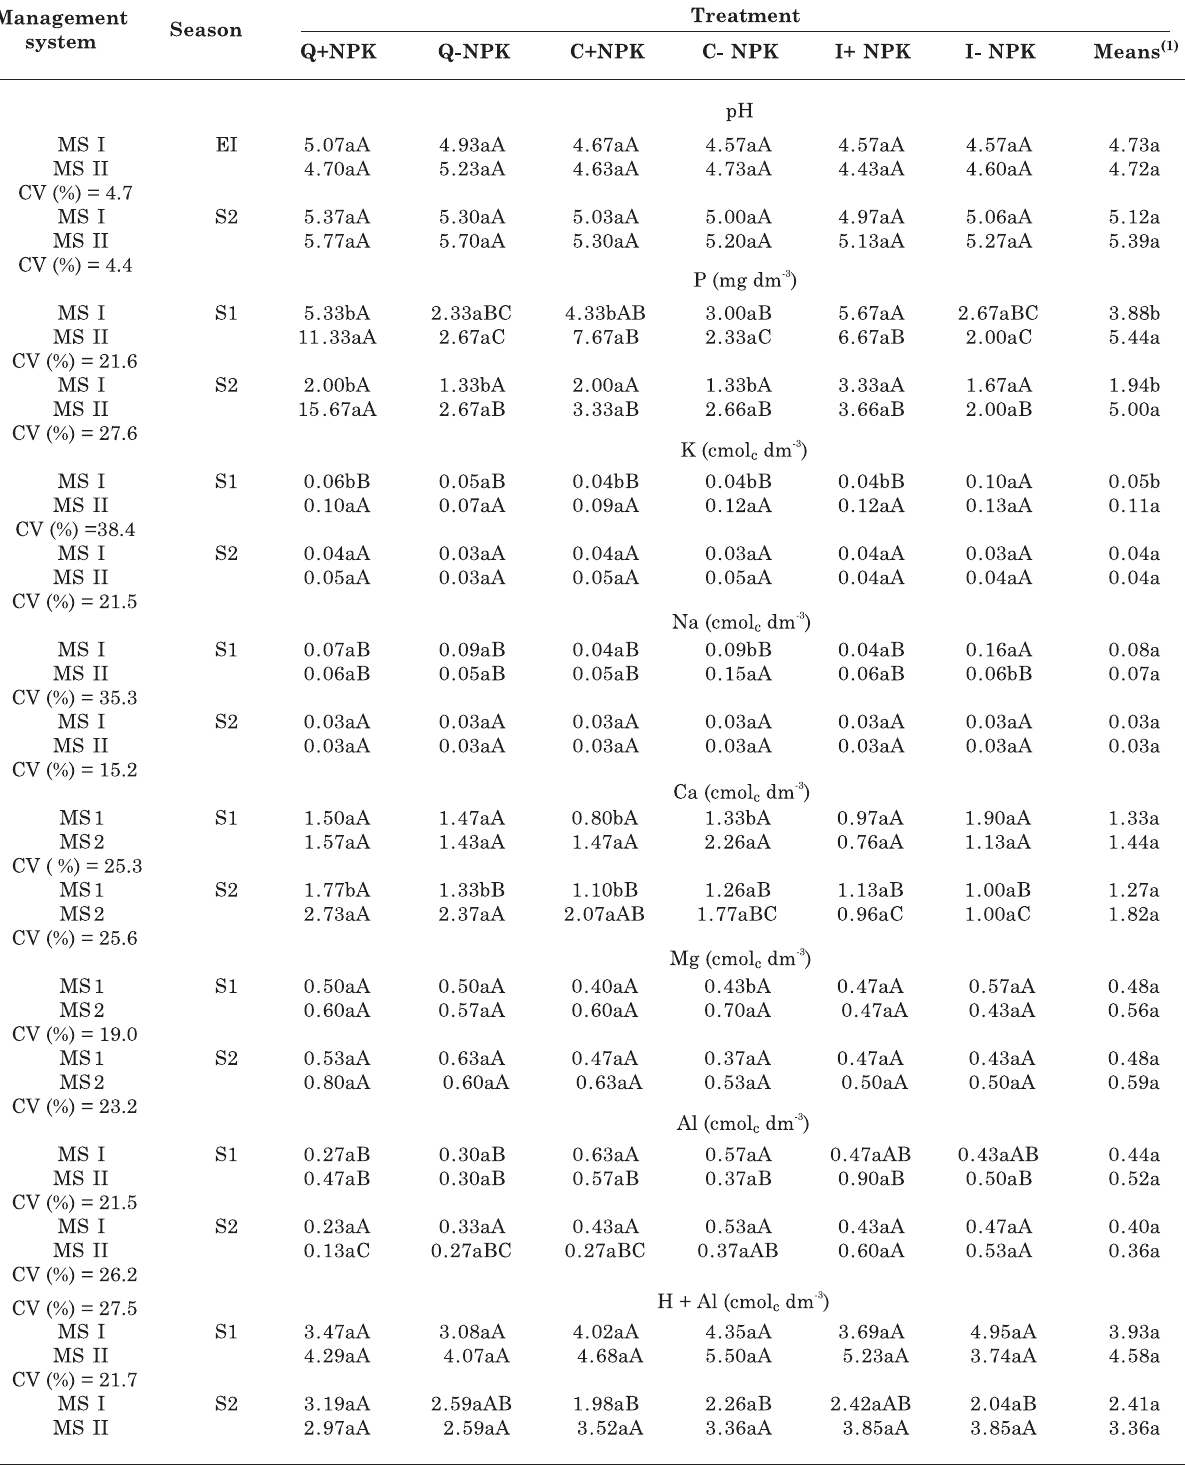
Table 3. Values of pH, phosphorus , potassium, sodium, calcium, magnesium, aluminum and potential